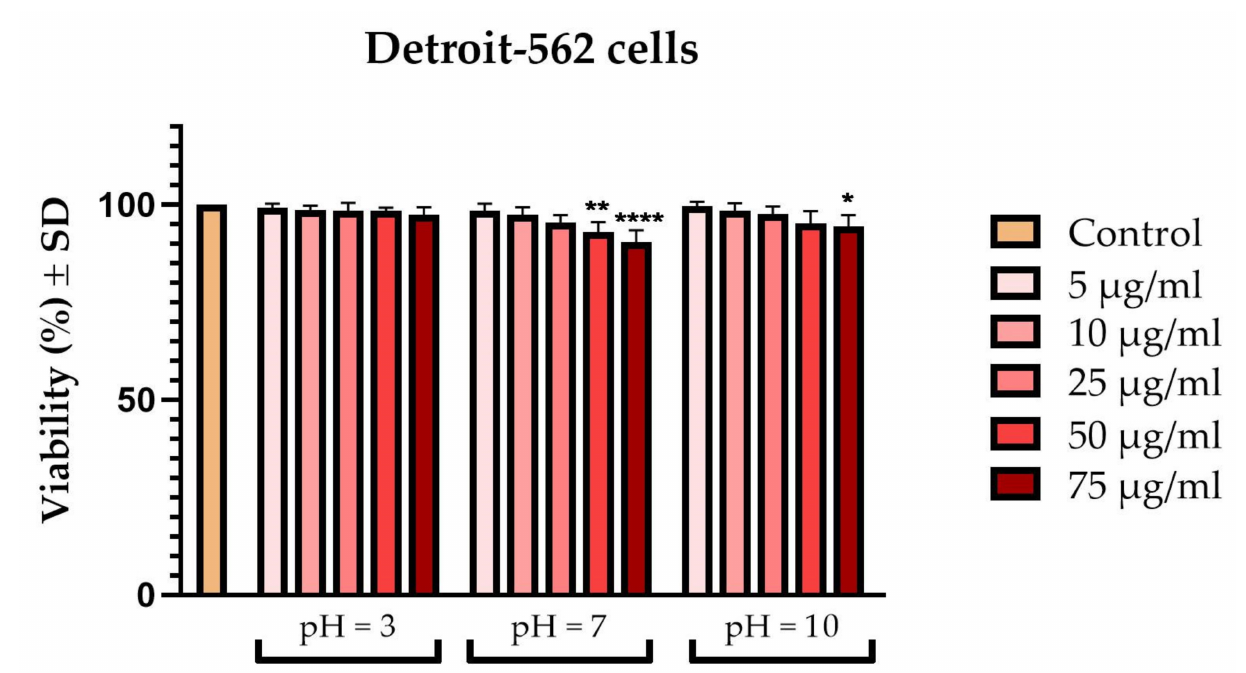
Figure 1. In vitro evaluation of the effect of P1 (5, 10, 25, 50, and 75 µ g/mL) suspended in artificial saliva with acidic pH (pH = 3), neutral pH (pH = 7), and basic pH (pH = 10) at the Detroit-562 cell line level after 72 h of treatment. The results are expressed as viability percentages (%) normalized to control cells (unstimulated) and expressed as mean values ± SD of three independent experiments performed in triplicate. The statistical difference between the control group and the P1-treated group was determined by applying one-way ANOVA, followed by Dunnett’s multiple post-test comparisons (* p < 0.05; ** p < 0.01; **** p <